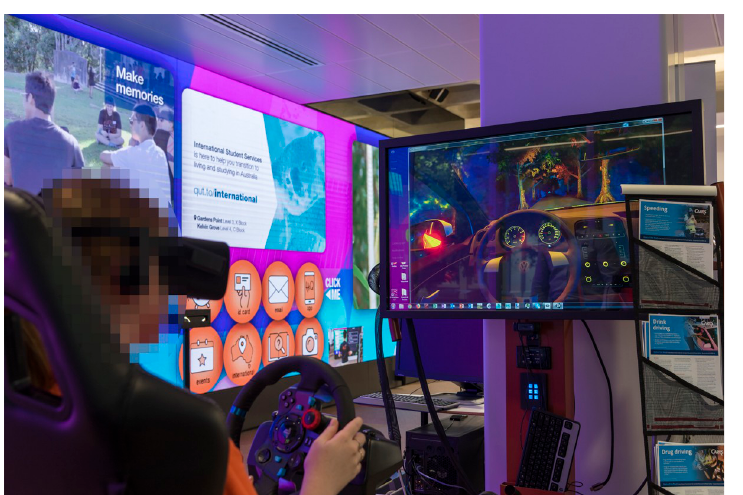
Fig 1. A participant, operating the driving simulator with VR